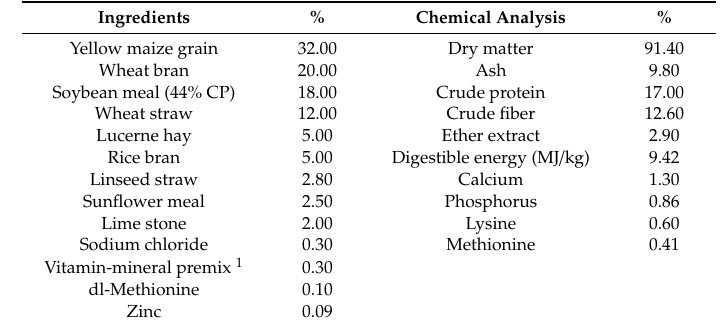
Table 1. Ingredient and chemical composition (as-fed basis) of the control diet fed to rabbits throughout the experimental periods.